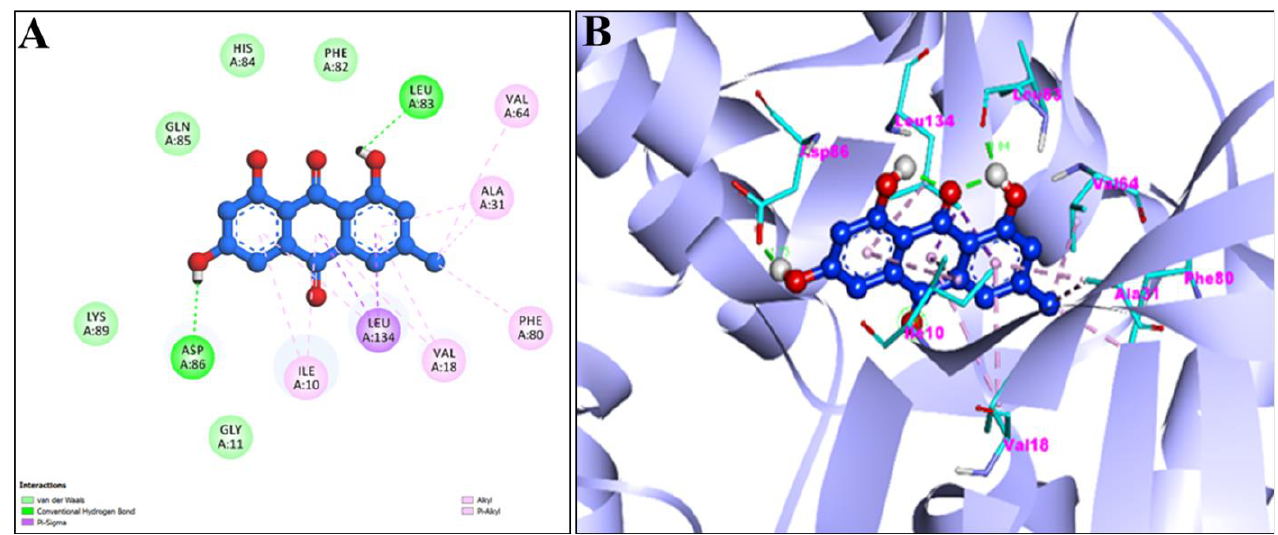
Figure 6. 2D ( A ) and 3D ( B ) representation of interaction of emodin (blue color) and cyclin-dependent kinase 2 (purple color with ribbon pattern) (PDB:6GUE). Table 1. Showing docking results of emodin with receptor molecules caspase-3, apoptosis regulator Bcl-2, TRAF2 and NCK-interacting protein kinase and cyclin-dependent protein kinase 2.